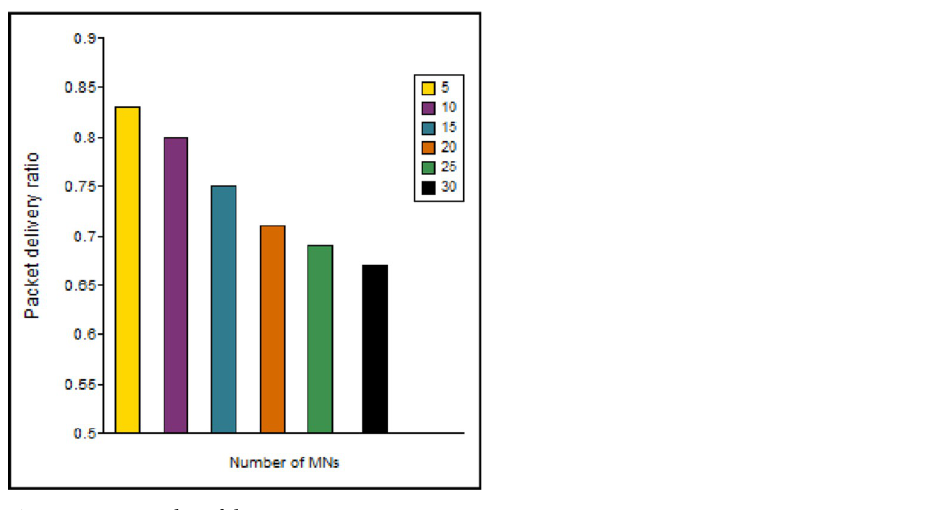
Fig 12. PDR vs number of the